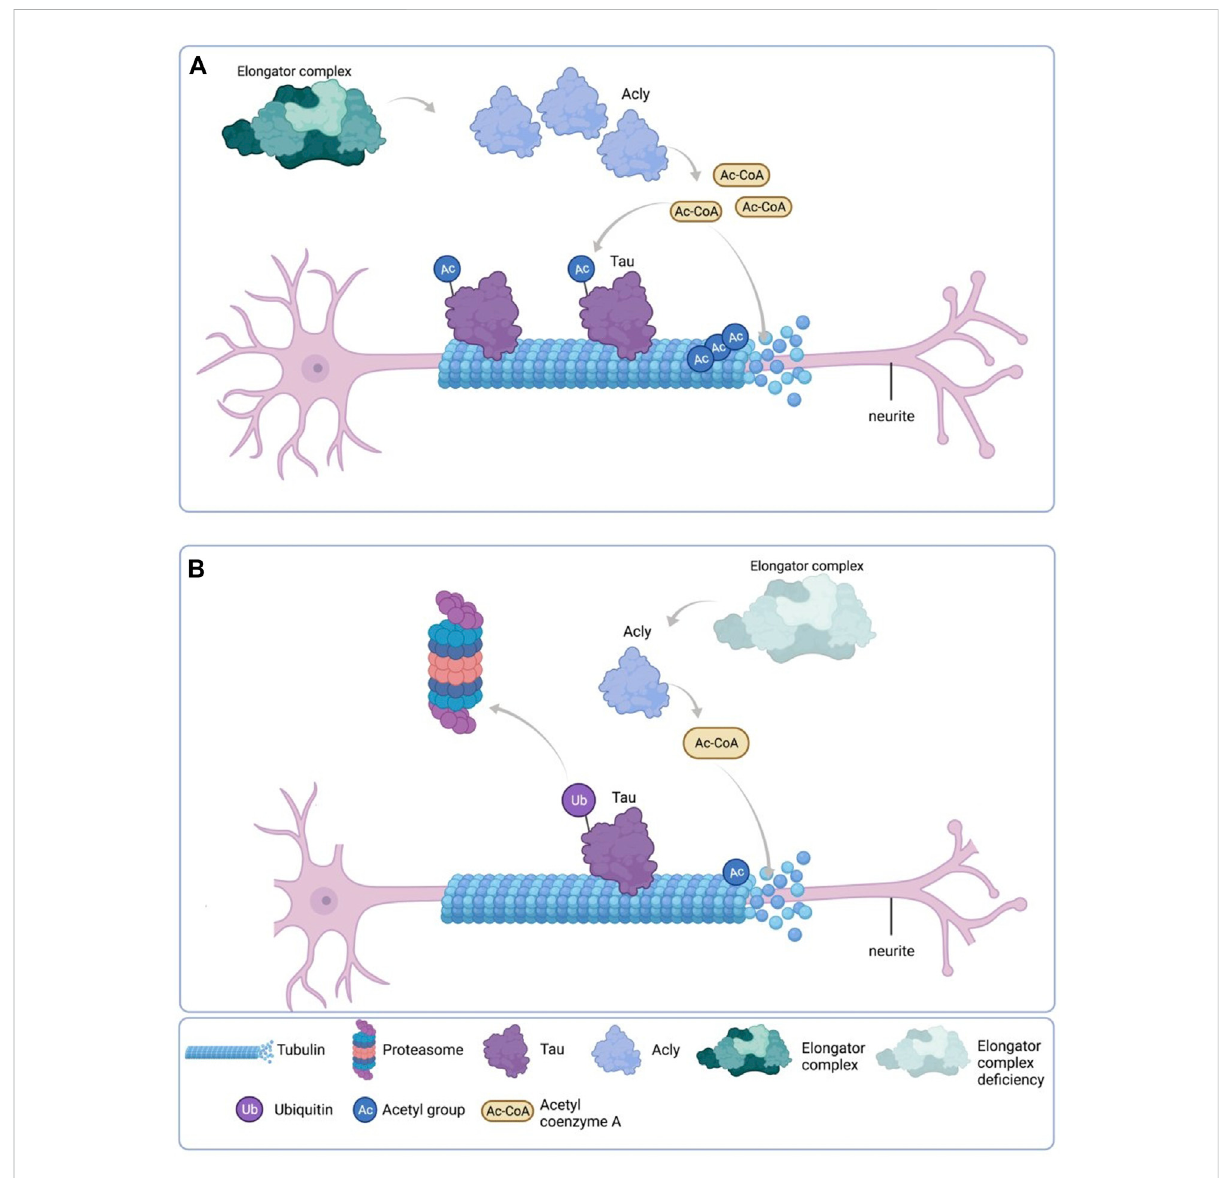
FIGURE 9 Schematic representation of the results. (A) Under normal Elongator complex activity, Acly ’ s enzymatic activity in the cytoplasm of neurons produces suf fi cient Ac-CoA for maintenance of acetylation levels of both Tau and MT via their respective acetyltransferases, contributing to normal neurite morphology. (B) Under Elongator complex de fi ciency (hElp1-KD), Acly ’ s enzymatic activity is compromised due to protein instability producing low Ac-CoA in the cytoplasm of neurons compromising acetylation levels required for maintenance of both Tau and MT causing polyubiquitylation and proteasomal degradation of Tau, contributing to MT instability and abnormal neurite morphology. Adapted from “ Neuron Anatomy ” ,byBioRender.com(September2020).Retrievedfromhttps://app.biorender.com/biorender-templates/t-5f5b7e6139954000b2bde860- neuron-anatomy Copyright 2022 by